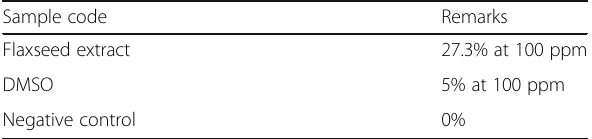
Table 4 Effect of FM phenolic extracts on thrombin